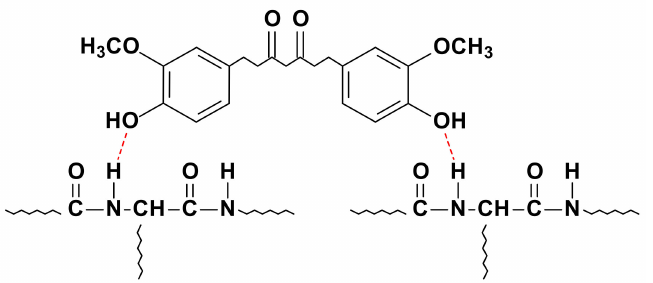
Figure 4. Schematic diagram of the interactions between collagen and THC by hydrogen bonding.